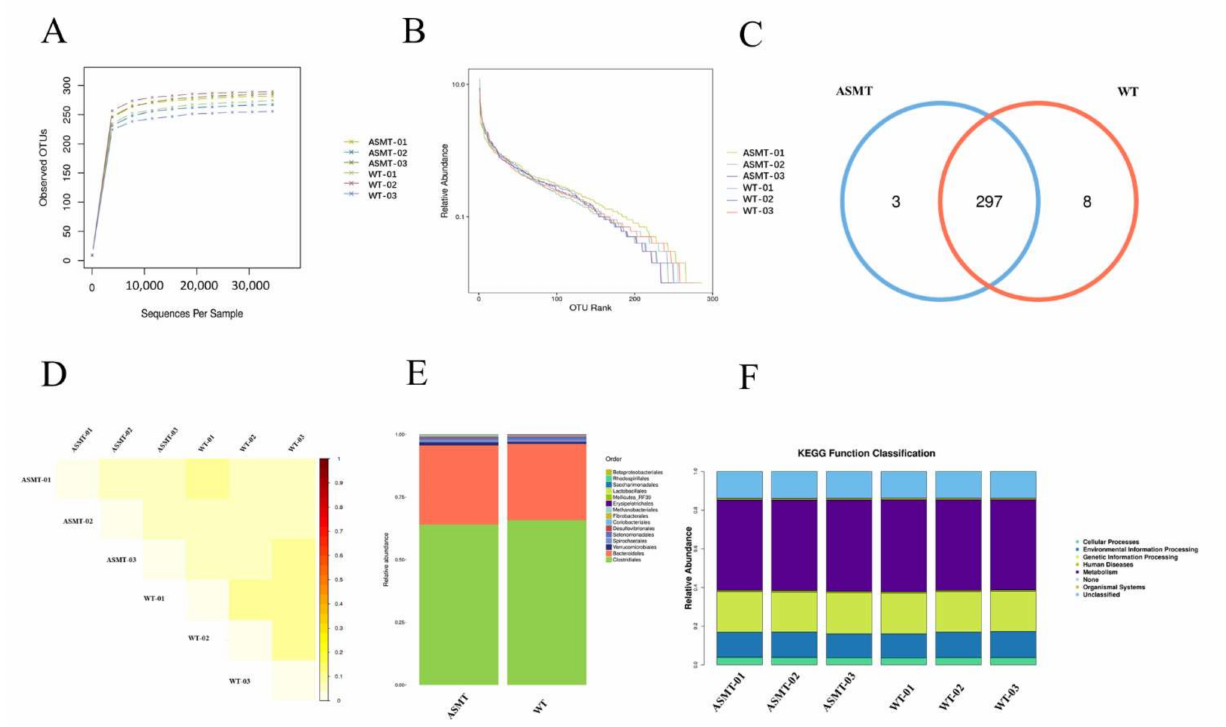
Figure 4. Gut microbiota distributions in transgenic (ASMT) and WT goats. ( A ) Dilution curve; ( B ) rank–abundance curve; ( C ) Venn diagrams; ( D ) distance matrix heat map; ( E ) histogram of distribution of species at the level of order; ( F ) heat map of KEGG Function Classification at the order level. Note: the transgenic goat ( n = 3), wild type ( n =